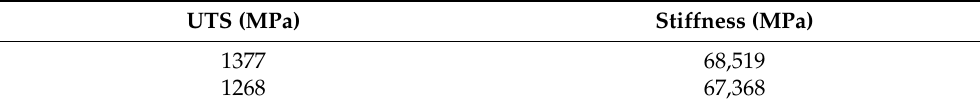
Table 6. Static tensile test results of the manufactured cross-ply plate with V f = 0.5963 and V v =